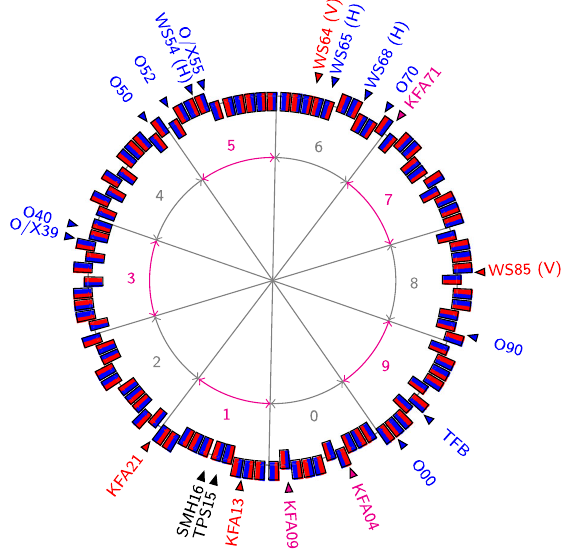
FIG. 1. Layout of the PS ring including the combined-function main magnets (red and blue rectangles for the focusing and defocusing parts, respectively) and the location of the key elements for MTE. The ten different sectors of the PS are indicated by the numbers and the radial offset between the rectangles accounts for the four different magnet types (see [7] for more detailed information).